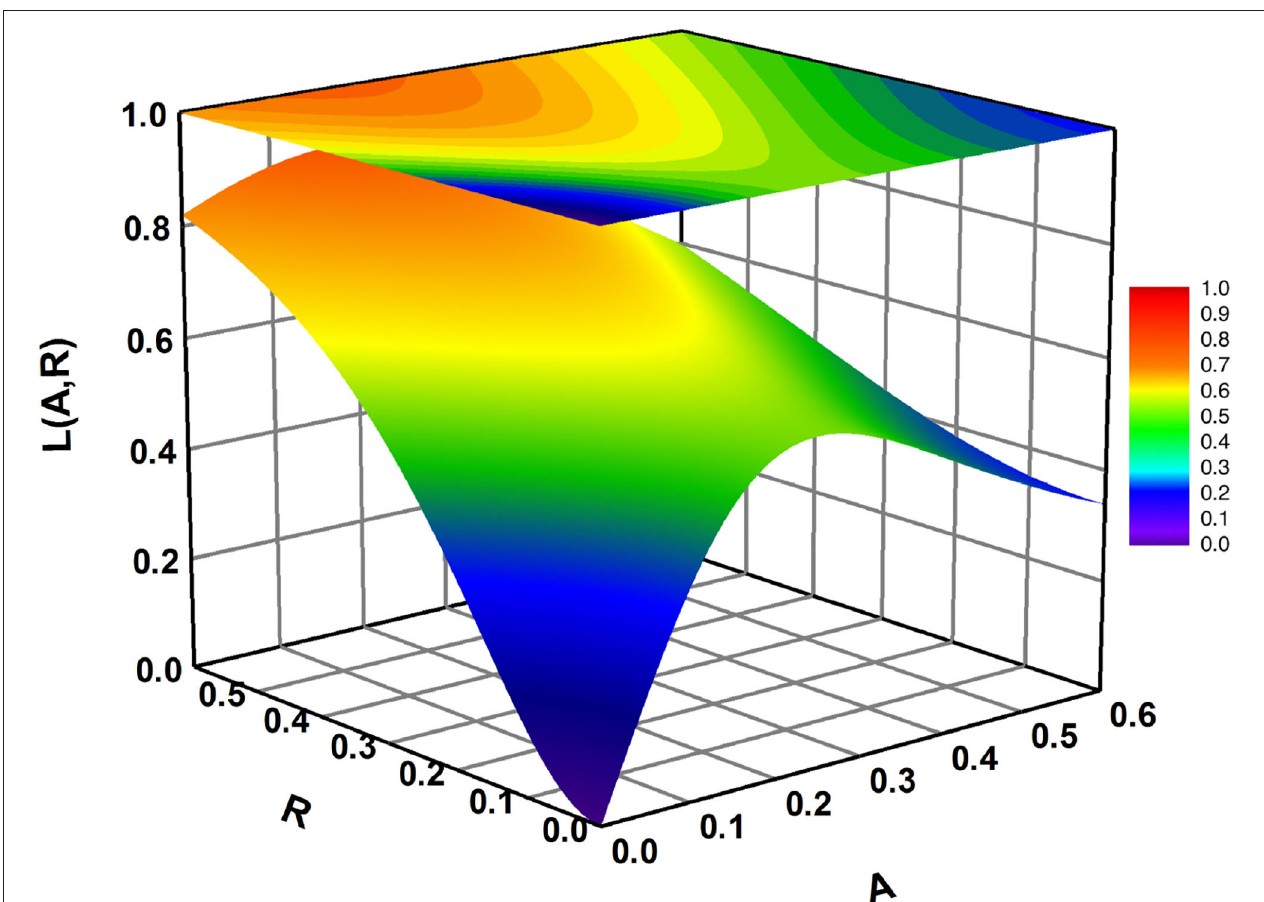
FIGURE 2 | Larval recruitment L ( A , R ) (Equation 2) as a function of both A and R . Parameter values are in Table 2